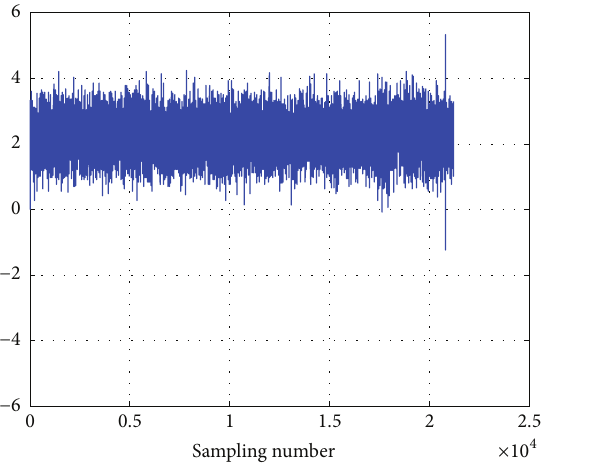
Figure 15: 𝛼 𝑦 for controlled